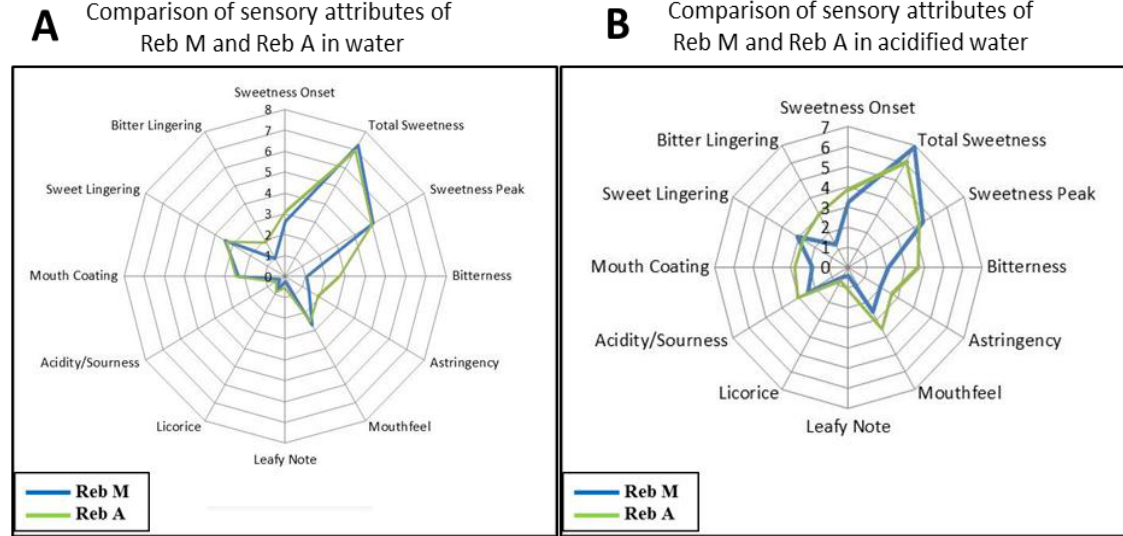
Figure 5. Comparison of sensory attributes of rebaudioside M (Reb M) ( 7 ) and rebaudioside A (Reb A) ( 1 ) in water ( A ). Comparison of sensory attributes of rebaudioside M and rebaudioside A in acidified water ( B ).